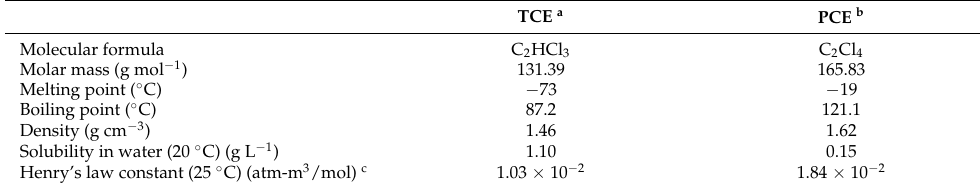
Table 1. Characteristics of TCE and PCE.